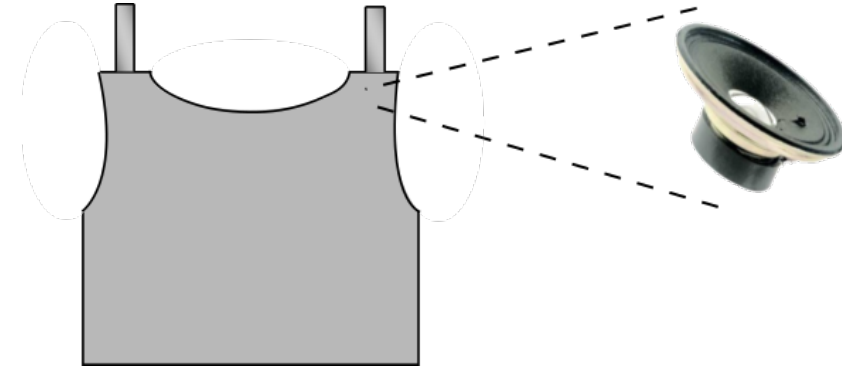
Figure 7. Location of the speaker for the kissing affection